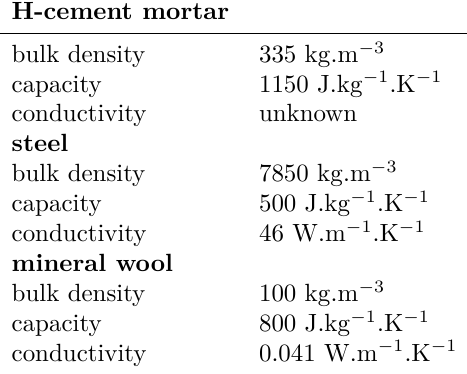
Figure 2. Experiment setup.